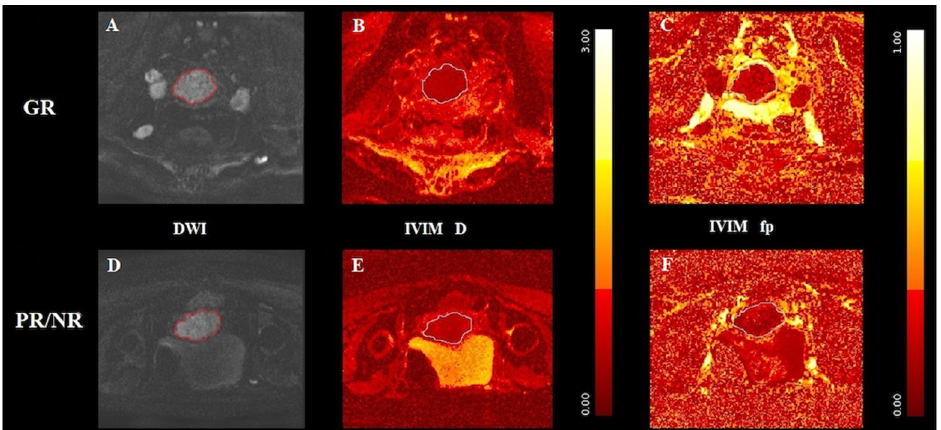
Figure 3. ( A , D ) A cervical squamous cell carcinoma displayed in DWI of good responder ( A ) and poor/non-responder ( D ), respectively; ( B , E ) the D map and ( C , F ) the fp map obtained from IVIM of the good responder GR in the top row and the poor/non-responder in the bottom row, respectively. Outlines indicate the tumor region. D is significantly higher in GR compared to PR/NR.